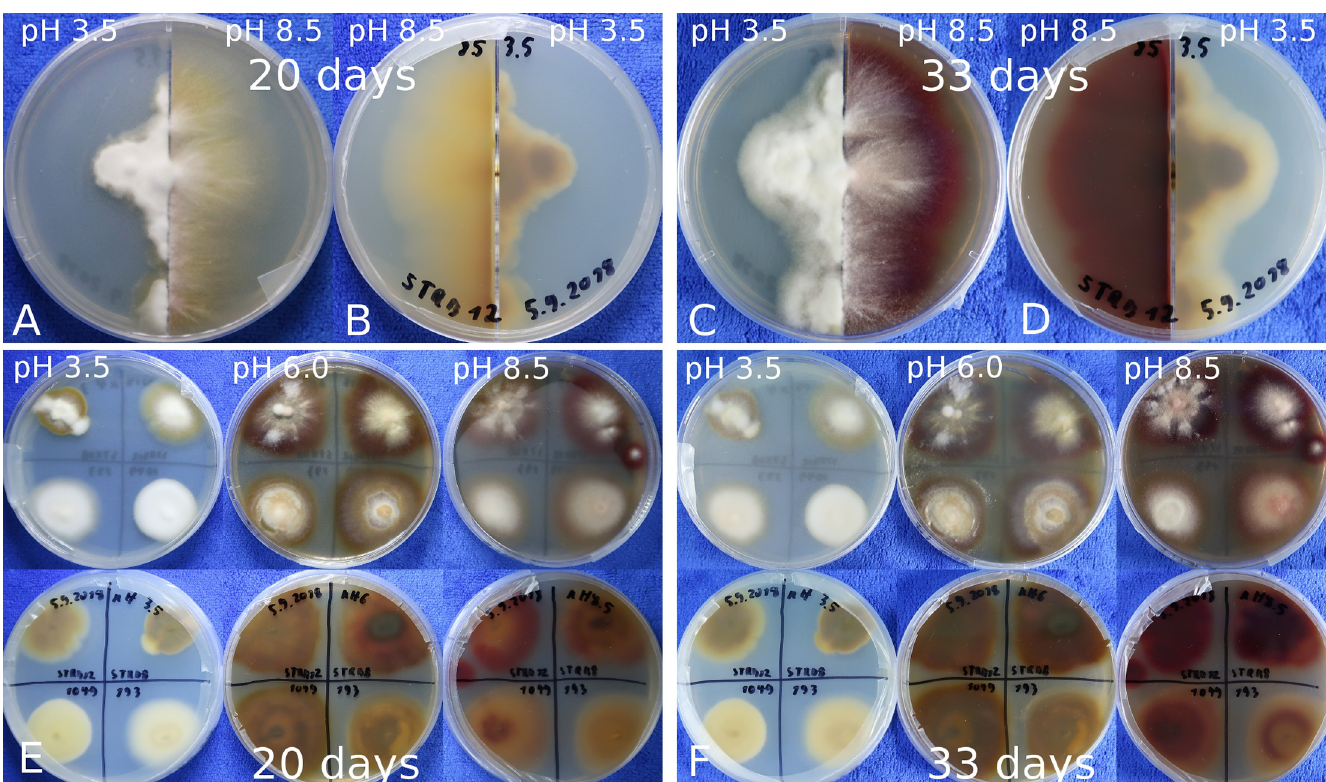
Fig 1. The color development of T . rubrum on Tr1 media depends on the pH. A-D: T . rubrum strain STRB012 grown on Tr1 medium in a 9 cm split plate. On right side of the plate the pH was adjusted to 3.5 and on the left side to 8.5 A, B: 20 day after inoculation a yellow to beige pigmentation is visible. C, D: 33 days after inoculation. At high pH a strong wine-red pigmentation is visible, whereas on low pH a brownish to beige pigmentation is visible. E-F: The four T . rubrum strains STRB008, STRB012, 193 and 1049 were inoculated on Tr1 medium with pH adjusted to 3.5 (left plate), 6 (middle) and 8.5 (right). E: 20 days after inoculation the first strains have a wine-pigmentation. F: 33 days after inoculation all strains have a wine-red pigmentation at high pH, whereas all strains stay whitish to beige under acid conditions.